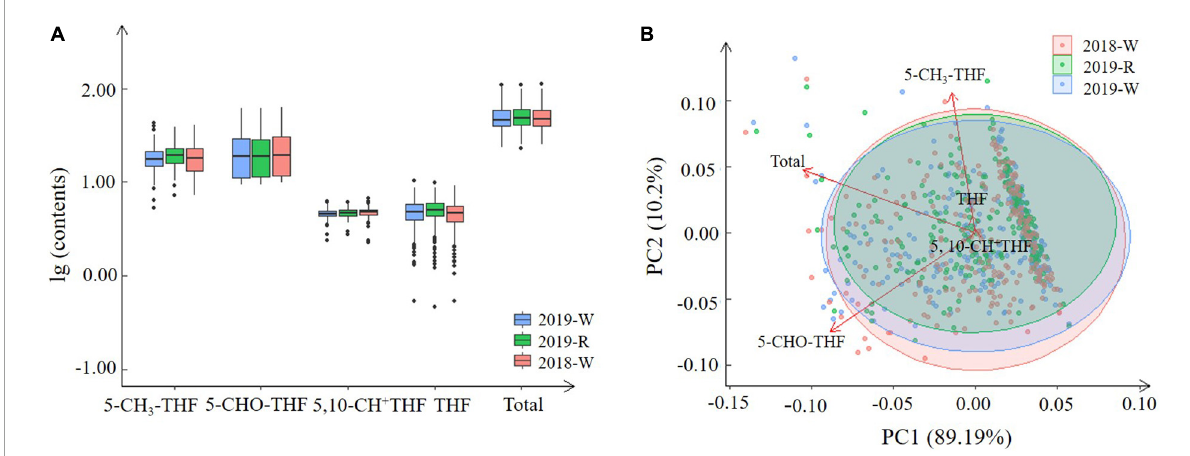
FIGURE1 Natural variation (A) and score plots (B) of total folate and four derivatives levels among the wheat genotypes harvested under the three environments.